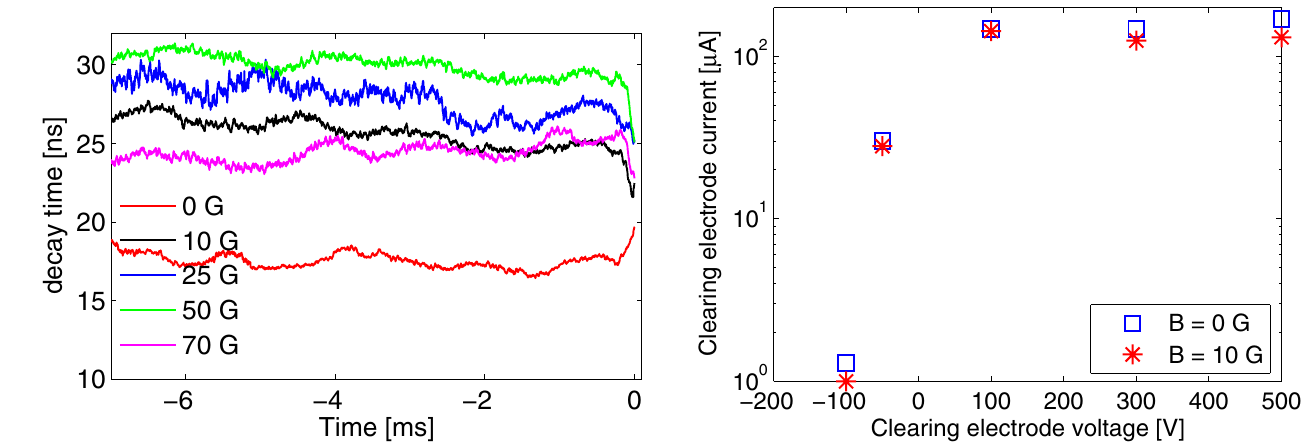
FIG. 13. (Color) Electron cloud decay time (cid:4) during the last 7 ms of the PS cycle for different magnetic fields. The decay time is not very sensitive on the bunch length, but increases when a magnetic field is present.